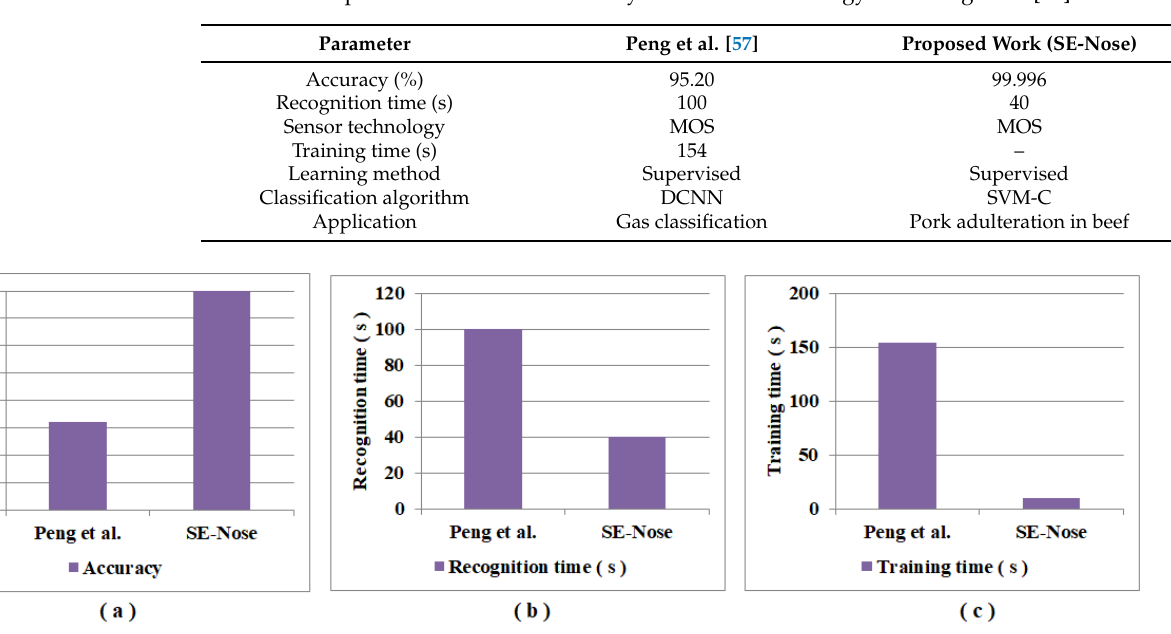
Figure 6. Graphical representation of a comparison of performance metrics: ( a ) accuracy; ( b ) recogni- tion time; and ( c ) the training time of Peng et al. [57] and the SE-Nose